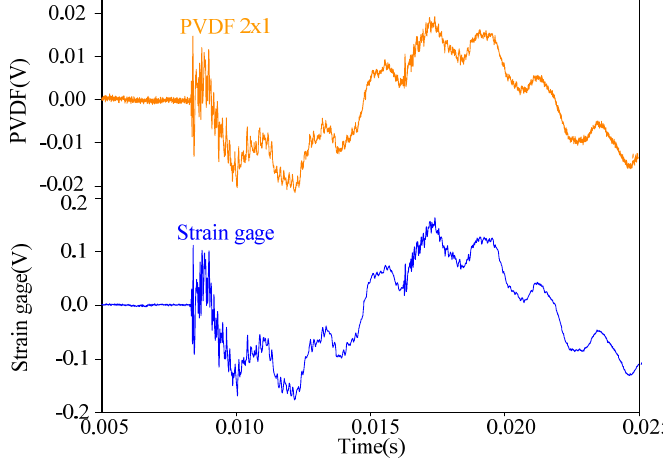
Figure 13. Measurement results of PVDF 2 × 1 and the strain guage with impact on location